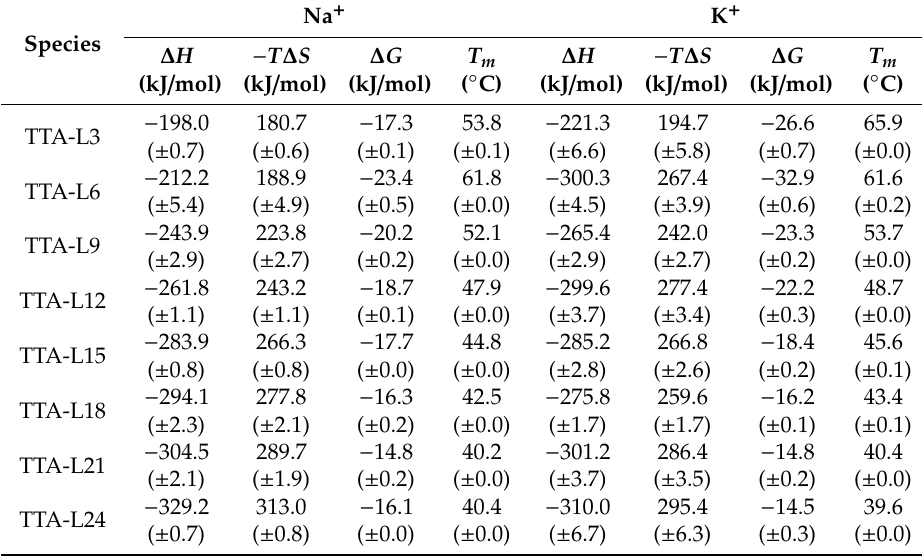
Table 2. Thermal dynamic parameters ( ∆ H , T ∆ S, and ∆ G (25 °C)) of TTT sequences in 100 mM NaCl or 100 mM KCl solutions, respectively.